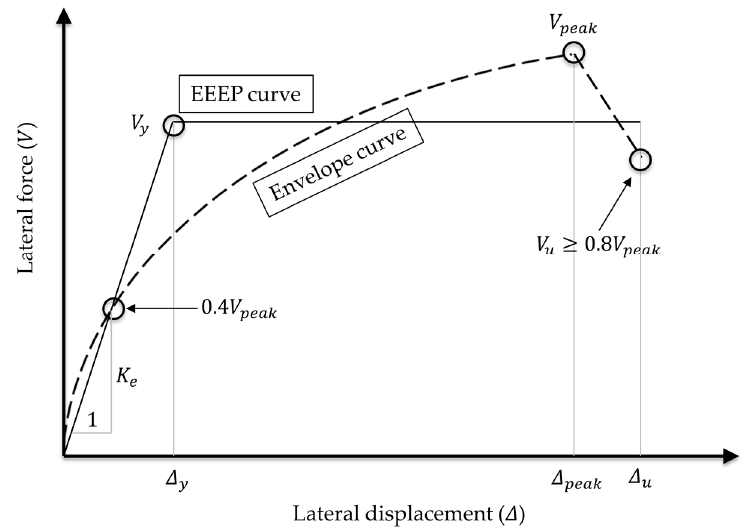
Figure 8. Definition of key parameters according to the American Society for Testing and